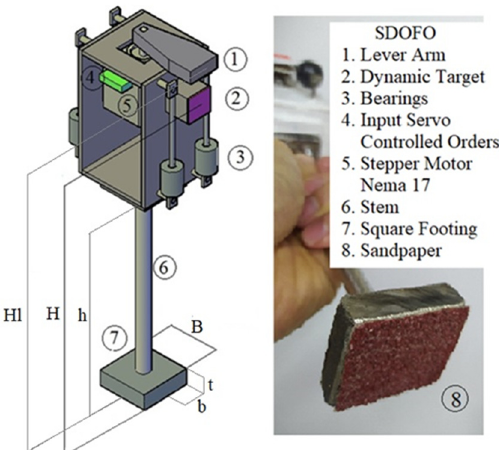
Figure 2. General sketch of the device. Nomenclature based on Table 2.